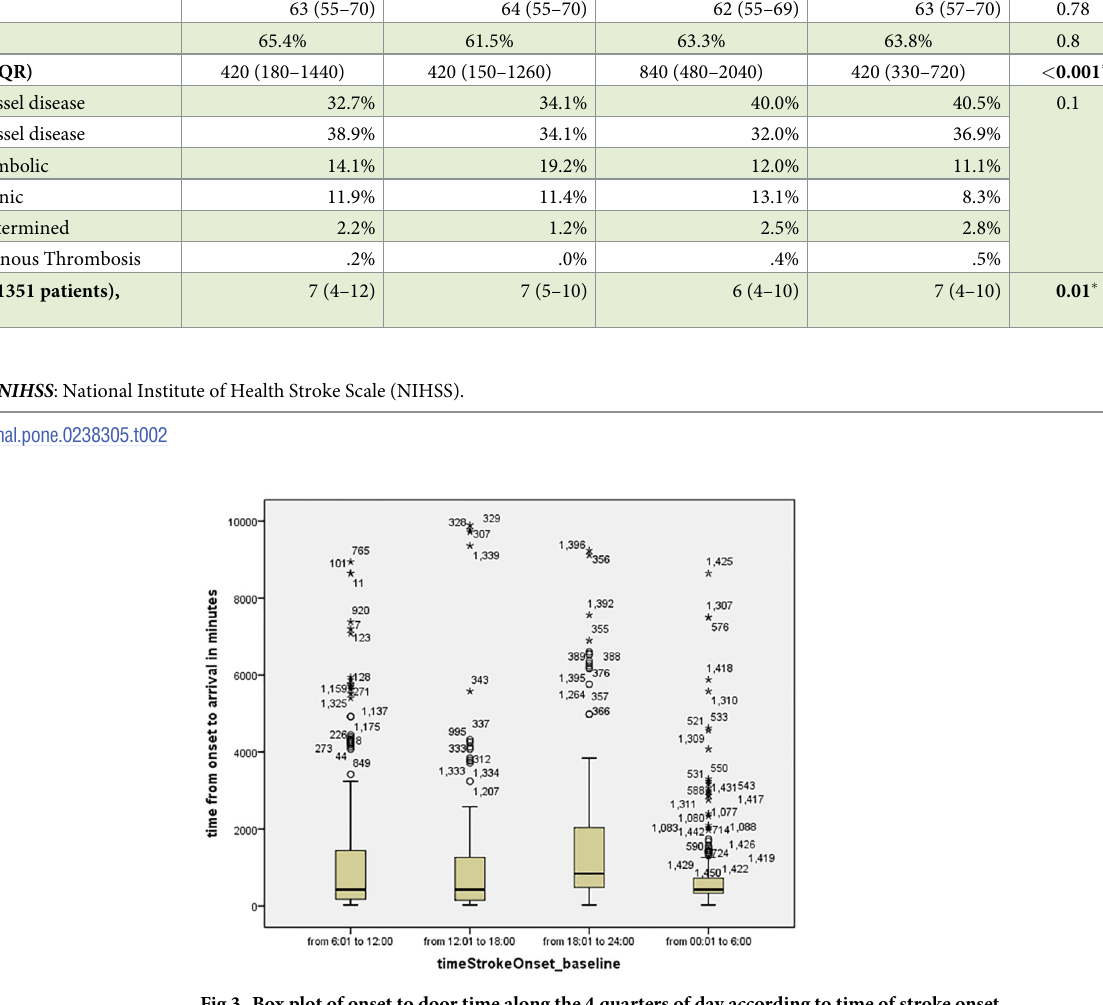
Fig 3. Box plot of onset to door time along the 4 quarters of day according to time of stroke onset.